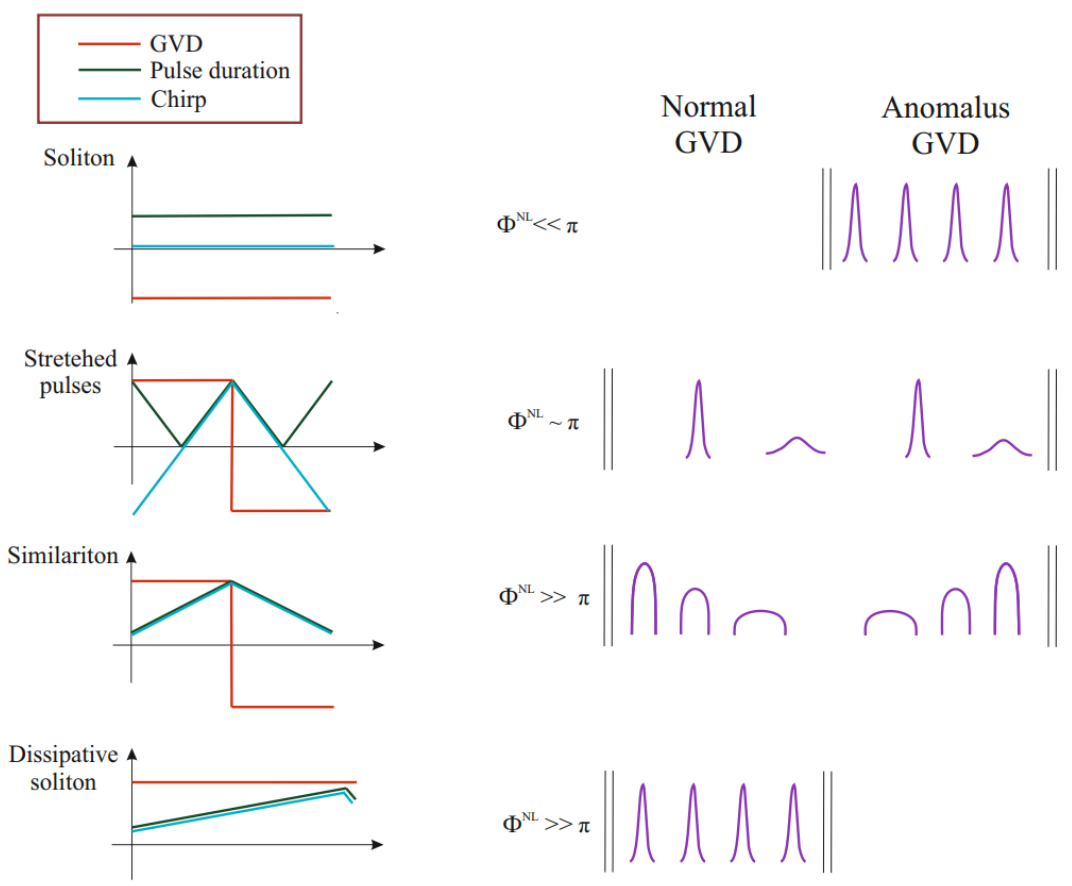
Figure 4. A simplified diagram of the evolution of pulses in resonators of different types. Double stripe shows the beginning and end of one resonator pass.